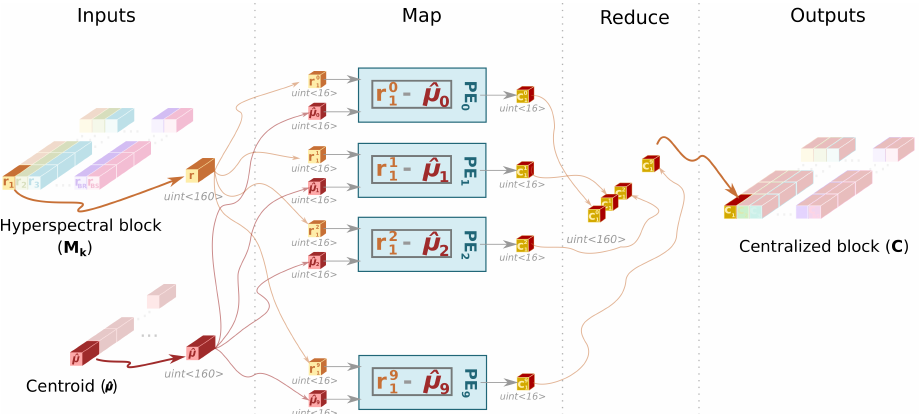
Figure 8. Map-reduce programming model and data packaging on Cent